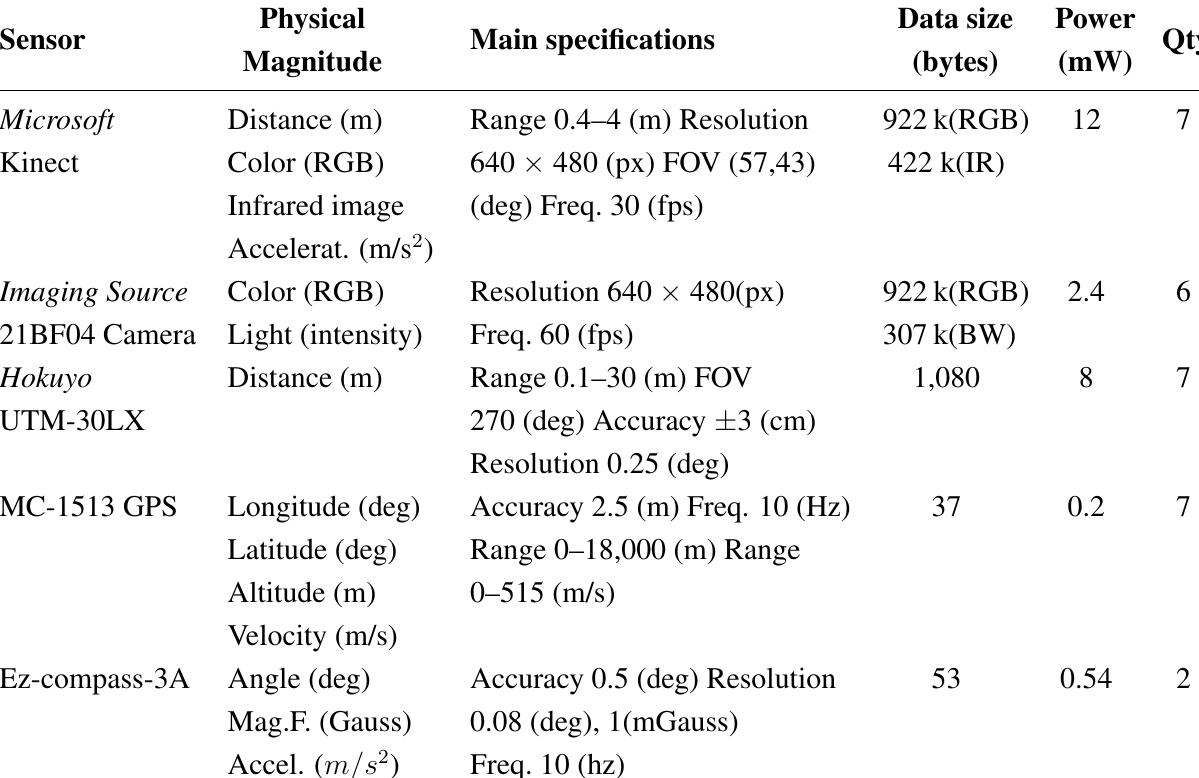
Table 2. Main features of the sensors mounted on the mobile